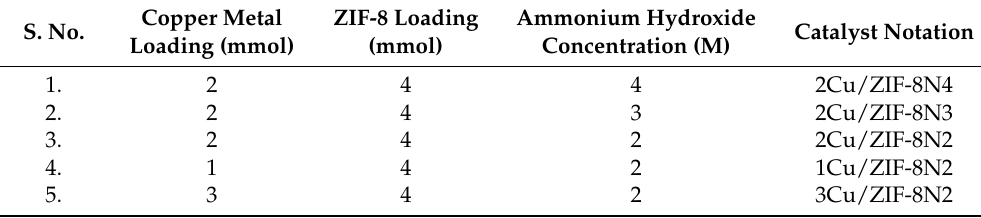
Table 2. Catalysts composition with Cu loading and ammonium hydroxides